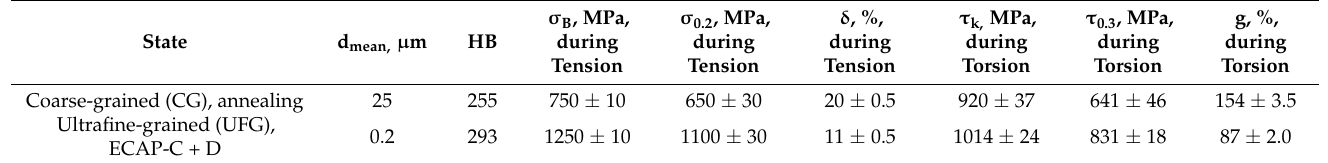
Table 1. Mean grain size and mechanical properties of Grade 4 Ti during tension and torsion